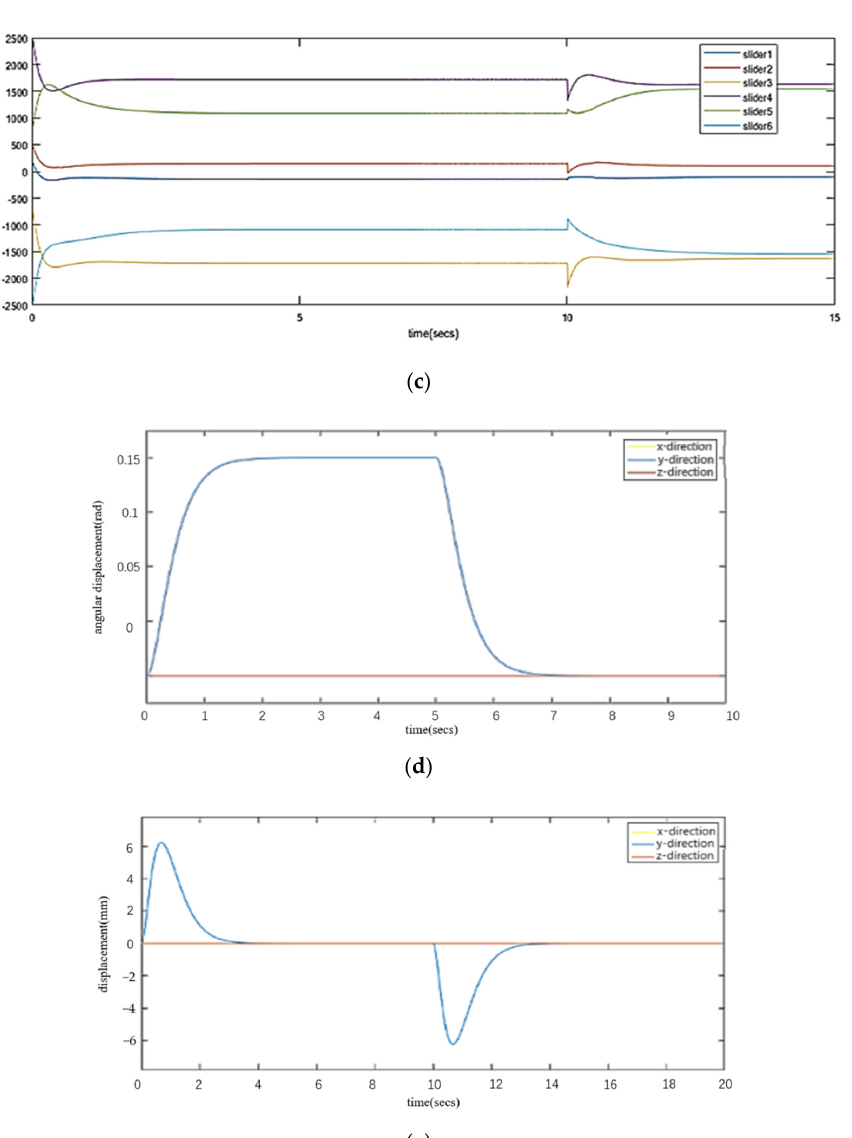
Figure 16. The optimized results are used to simulate the motion of the platform so as to obtain the motion and force of the platform and linear pair: ( a ) displacement of linear pair; ( b ) speed of linear pair; ( c ) drive of linear pair; ( d ) angular displacement of the platform; ( e ) displacement of platform.